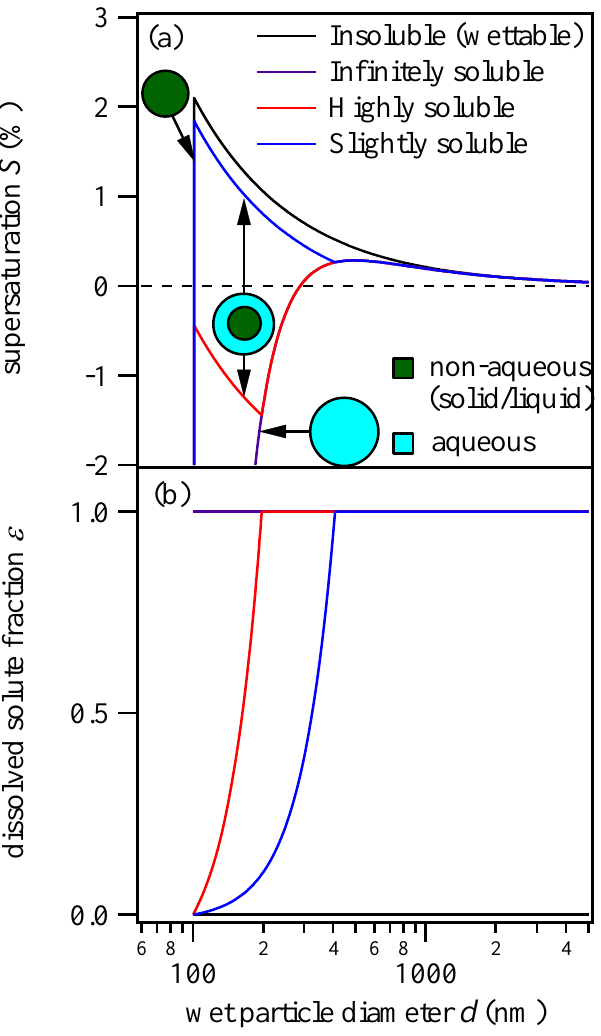
Fig. 1. Examples of K¨ohler curves for infinitely soluble (purple), highly soluble (red), slightly soluble (blue), and insoluble (black) particles. The calculations were conducted for input parameters of { M , ρ , σ , d 0 }={ 0.146kgmol − 1 , 1362kgm − 3 , 0.072Jm − 2 , 100nm } . The value of C was taken as 0.15 ( v/v ) for highly soluble particles and 0.015 ( v/v ) for slightly soluble particles. Further explanation is provided in the